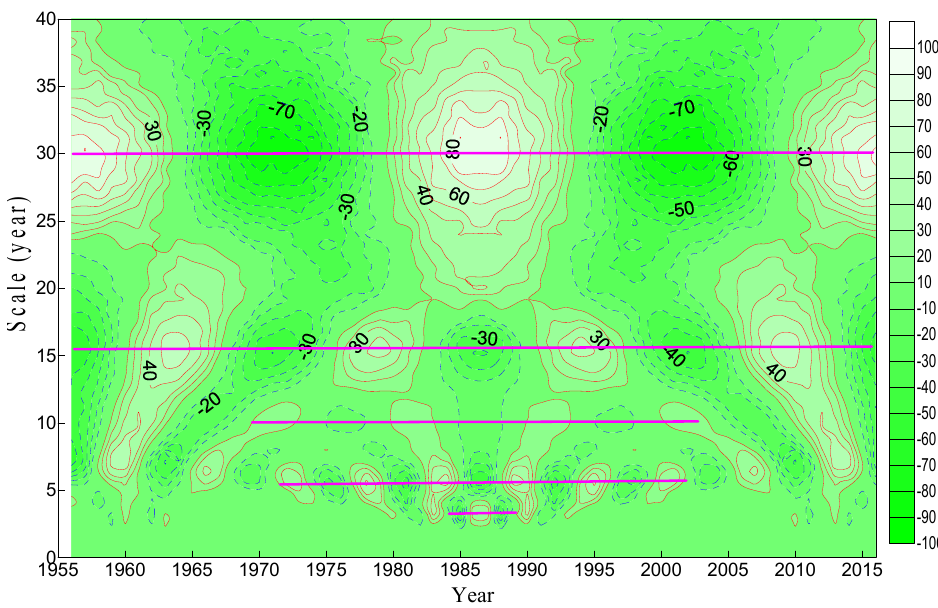
Figure 6. Real part coefficients contour map of streamflow at Toudauguai station.